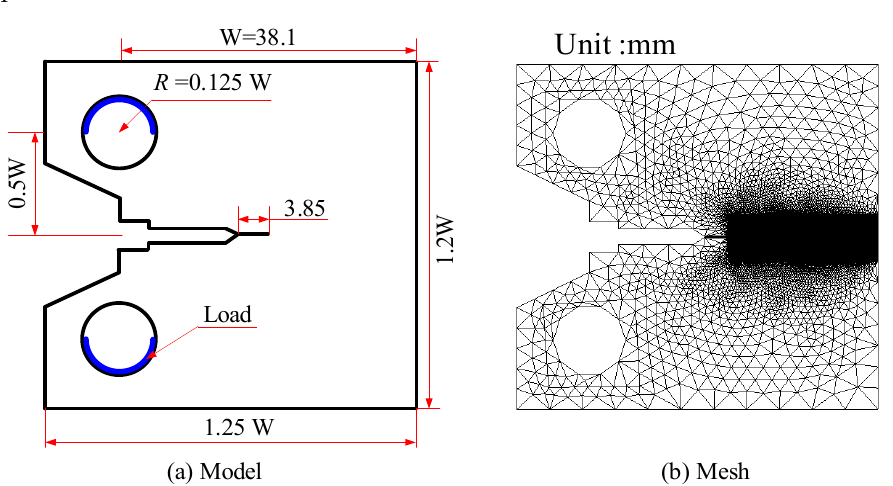
Figure 11. Model diagram of Case 2: ( a ) geometry model, ( b ) FE mesh. Table 2. The parameter values in Case 2 [3].